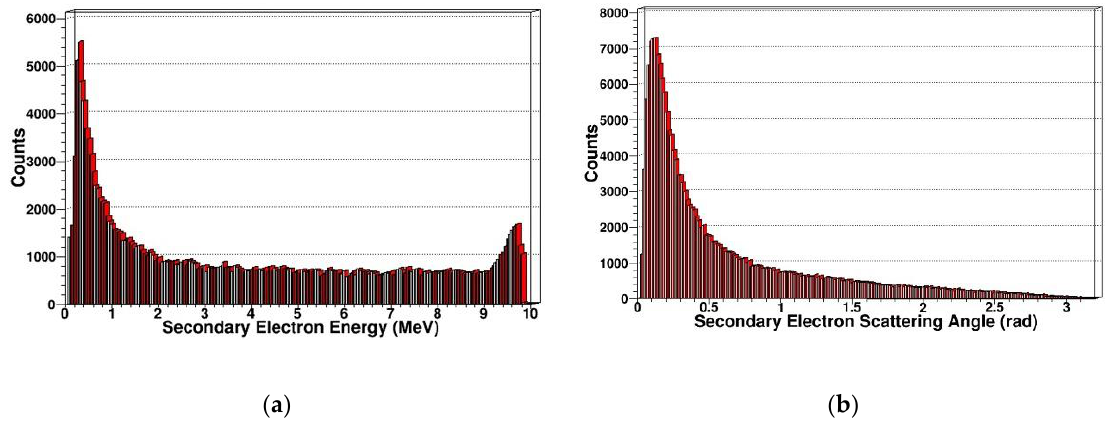
Figure 17. Secondary electrons in SDD generated by 14 MeV gammas: ( a ) Energy spectrum of secondary electrons; ( b ) scattering angle distribution of secondary electrons.